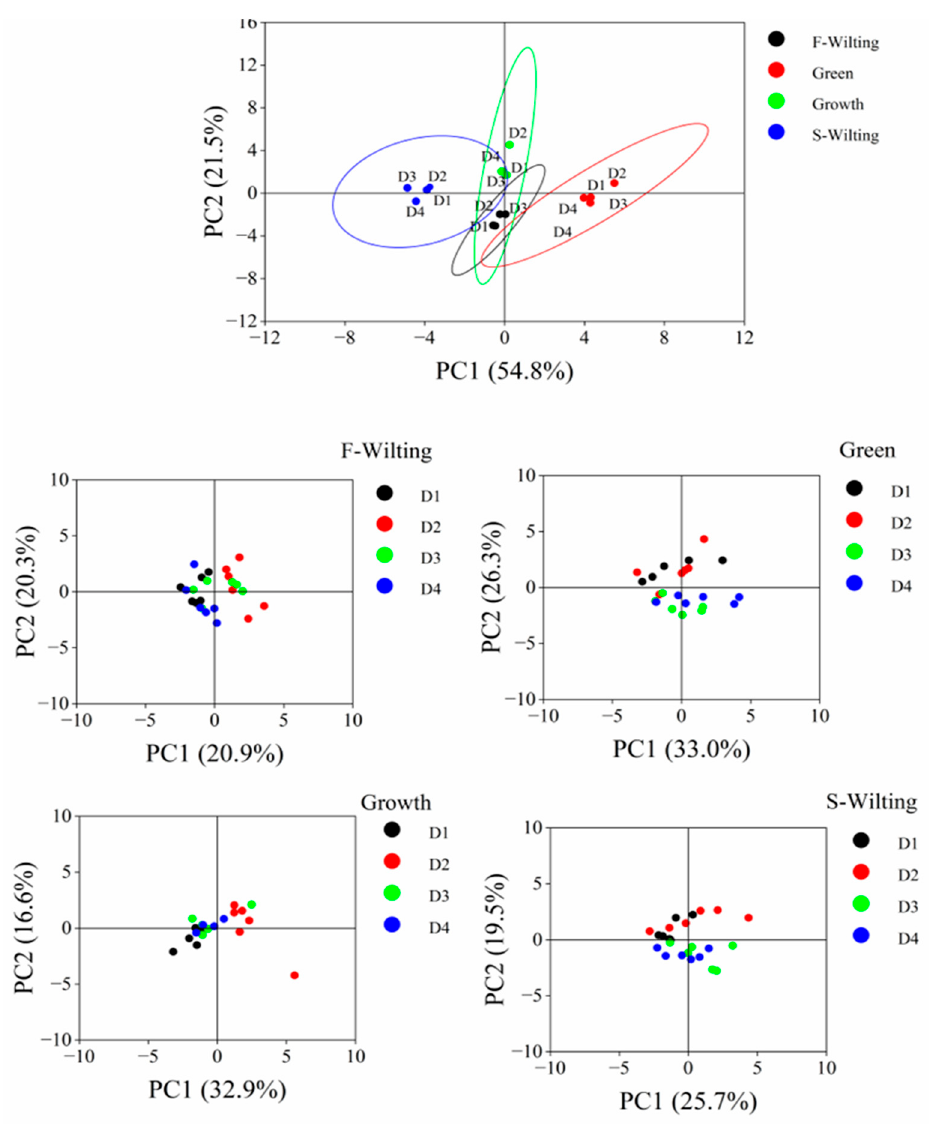
Figure 4. Principal component analysis of different growth stages and different density treatments.